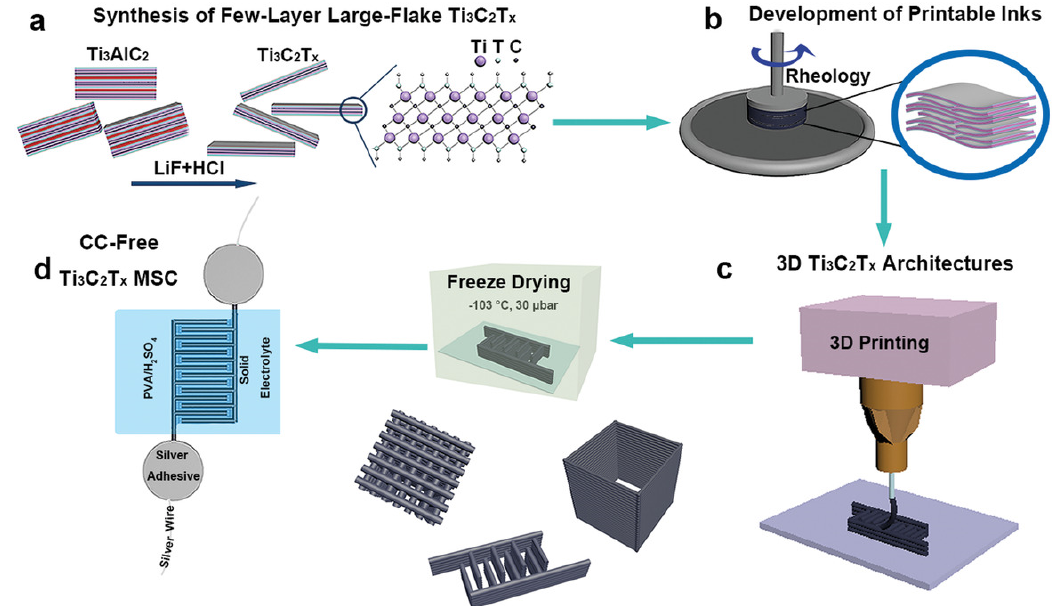
Figure 10. Schematic illustration of the manufacturing steps for 3D printing of freestanding MXene and MSC. ( a ) Synthesis process of Ti 3 C 2 T x MXene. ( b ) Preparation of Ti 3 C 2 T x inks at neutral pH. ( c ) The 3D printing of inks with ideal viscoelastic properties to manufacture various 3D design objects. ( d ) Solid-state MSC manufactured by 3D printing [61]. Copyright 2019, Wiley-VCH.